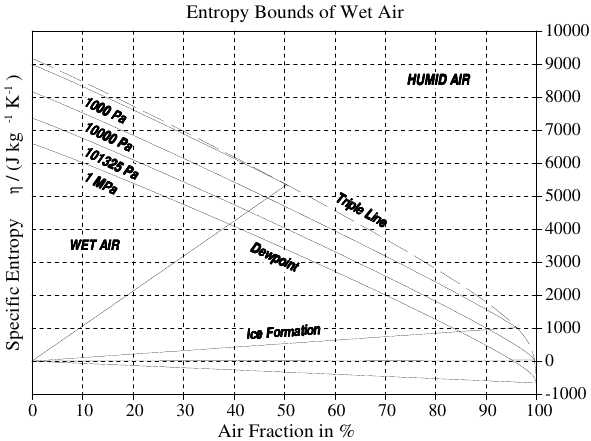
Fig. 9 Valid entropy values of wet air computed from Eq. (5.64) as arguments of enthalpy ( ) Pwh ,, AAW η are restricted to triangular regions, depending on the air fraction w A between 0 and 100% for selected pressures P as shown. At the upper entropy bound, the liquid phase is completely evaporated, given by the solution T ( A , P ) of case 2 in Appendix A.10, indicated as the “Dewpoint” lines in the figure. At the lower bound, the condensate of the wet-air sample starts freezing, Eq. (5.5), indicated here as the lines radiating from ( η , A), and referred to as “Ice Formation” lines. The envelop on which the triangles’ air-fraction maxima are located is the triple line, shown dashed, where ice, liquid water and vapour coexist in the presence of air, as described in Sect. 5.10, Eq. (S28.8). Note that the vapour-pressure lowering of water due to dissolved air is neglected in the equations. Freezing curves were computed with the library functions ice liq meltingtemperature si and curves